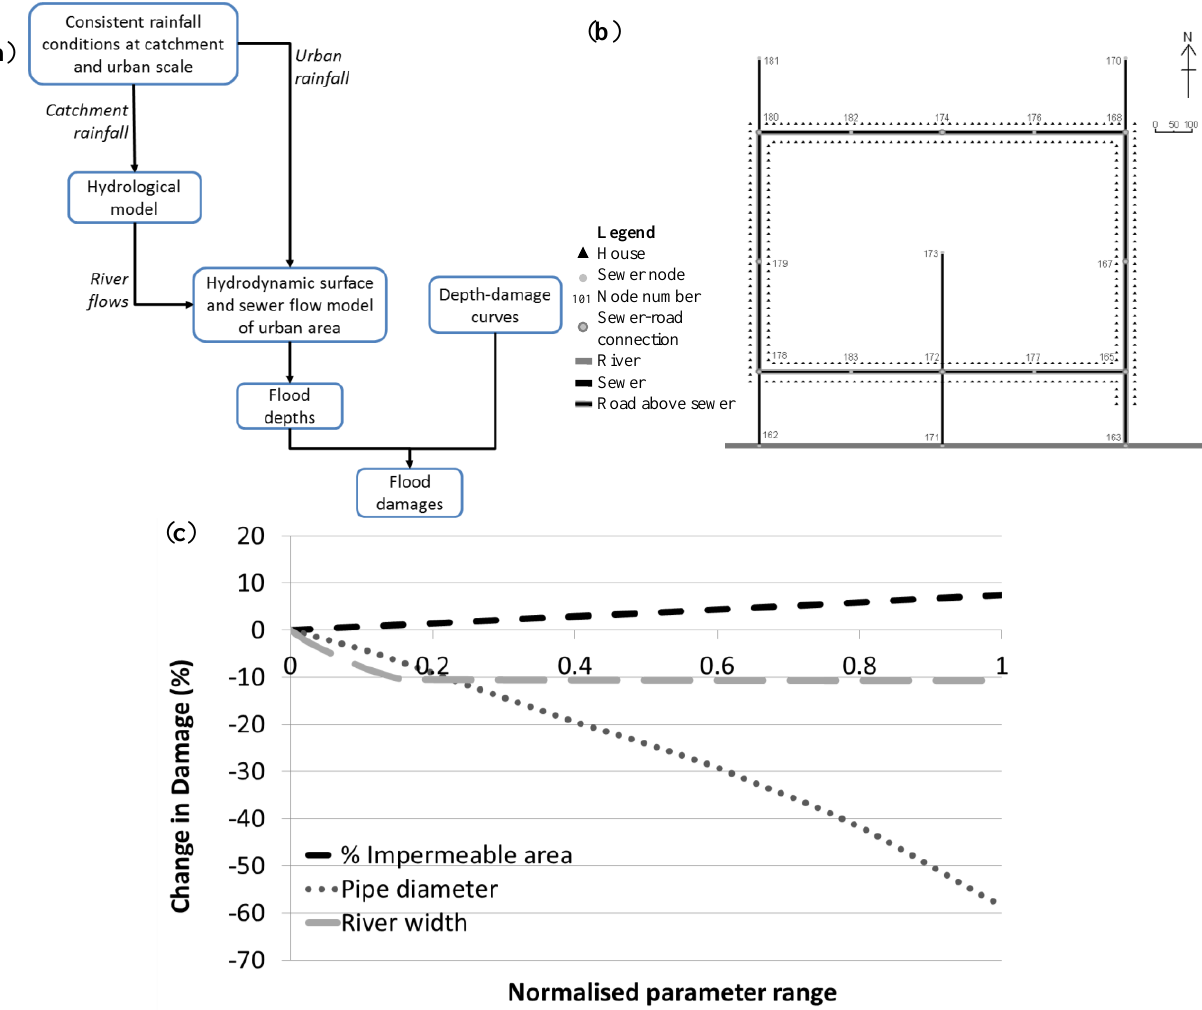
Figure 2. ( a ) Framework for assessing multiple sources of flood risk. ( b ) Overview of the urban area and drainage network case study. ( c ) Sensitivity of engineering variables (after